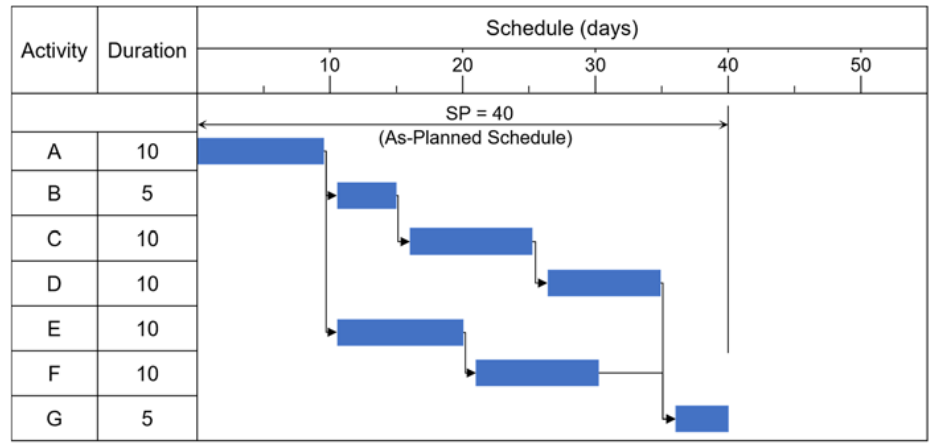
Figure 1. As ‐ planned schedule of a sample project. Figure 1. As-planned schedule of a sample